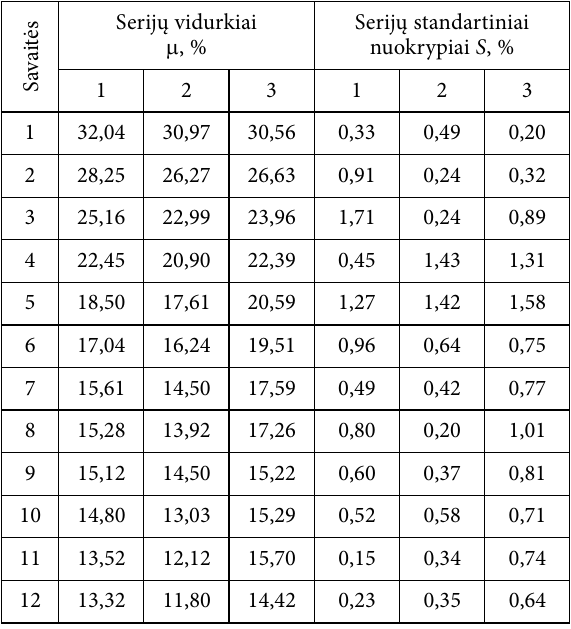
Table 2. Statistical criteria for drying concrete cubes